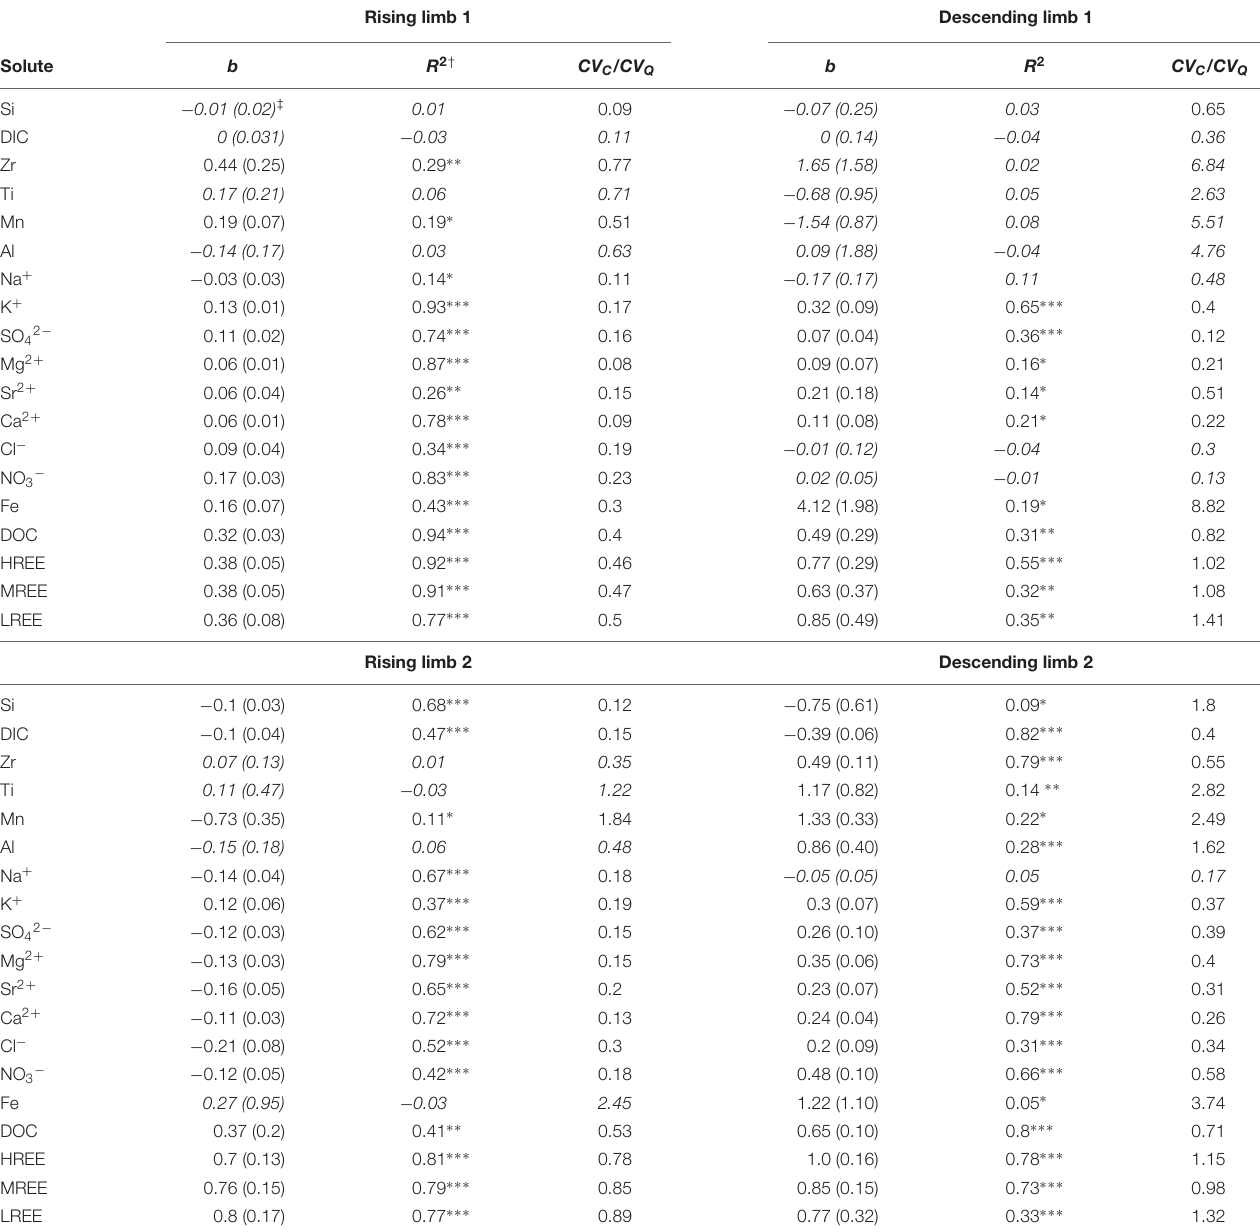
TABLE 2 | Summary of power law fit (Eq. 1) and coefficient of variance (Eq. 2) for C-Q relations in the LJ stream. Rising limb 1 Descending limb